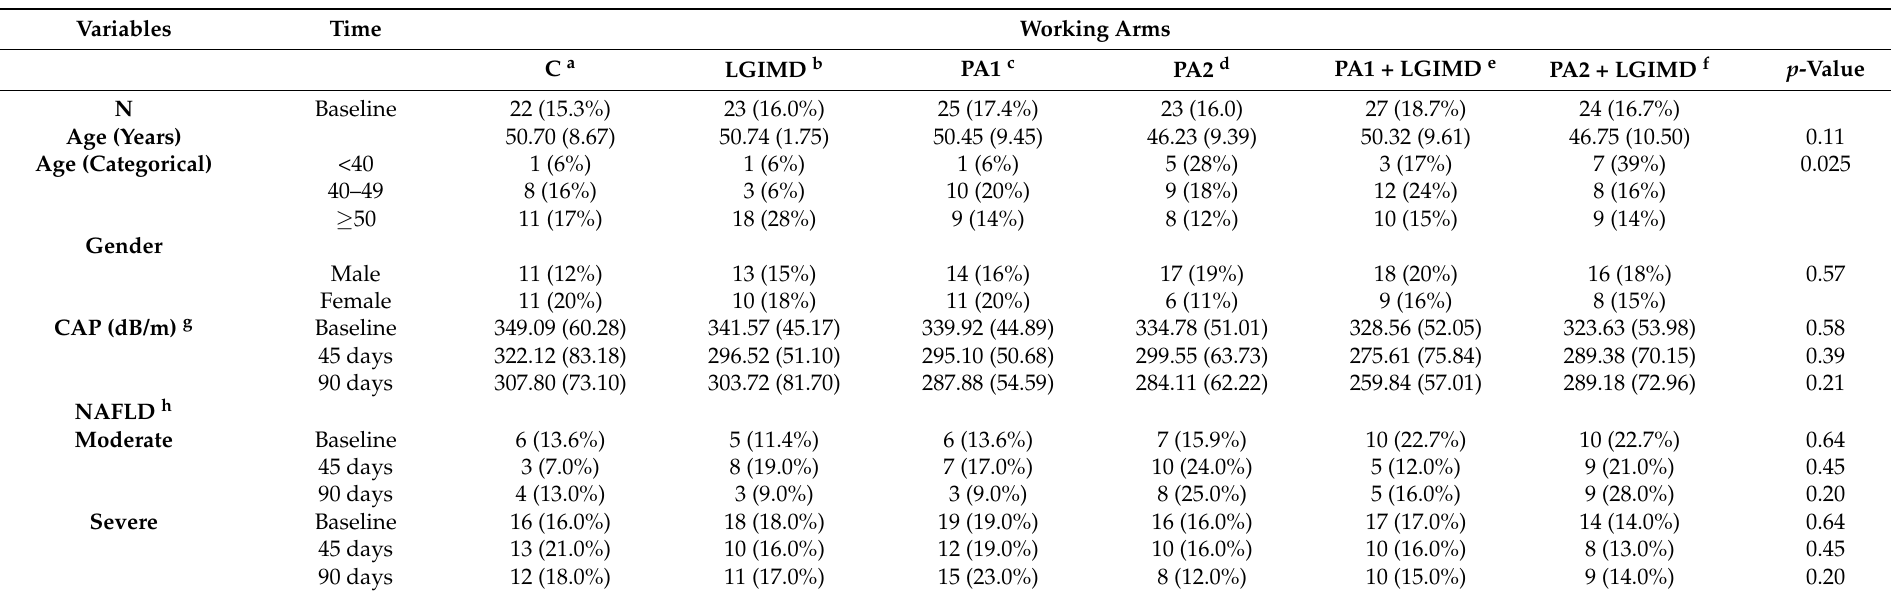
Table 1. Characteristics of Participants by Intervention Arms and Time. NutriAtt Trial, Castellana Grotte,